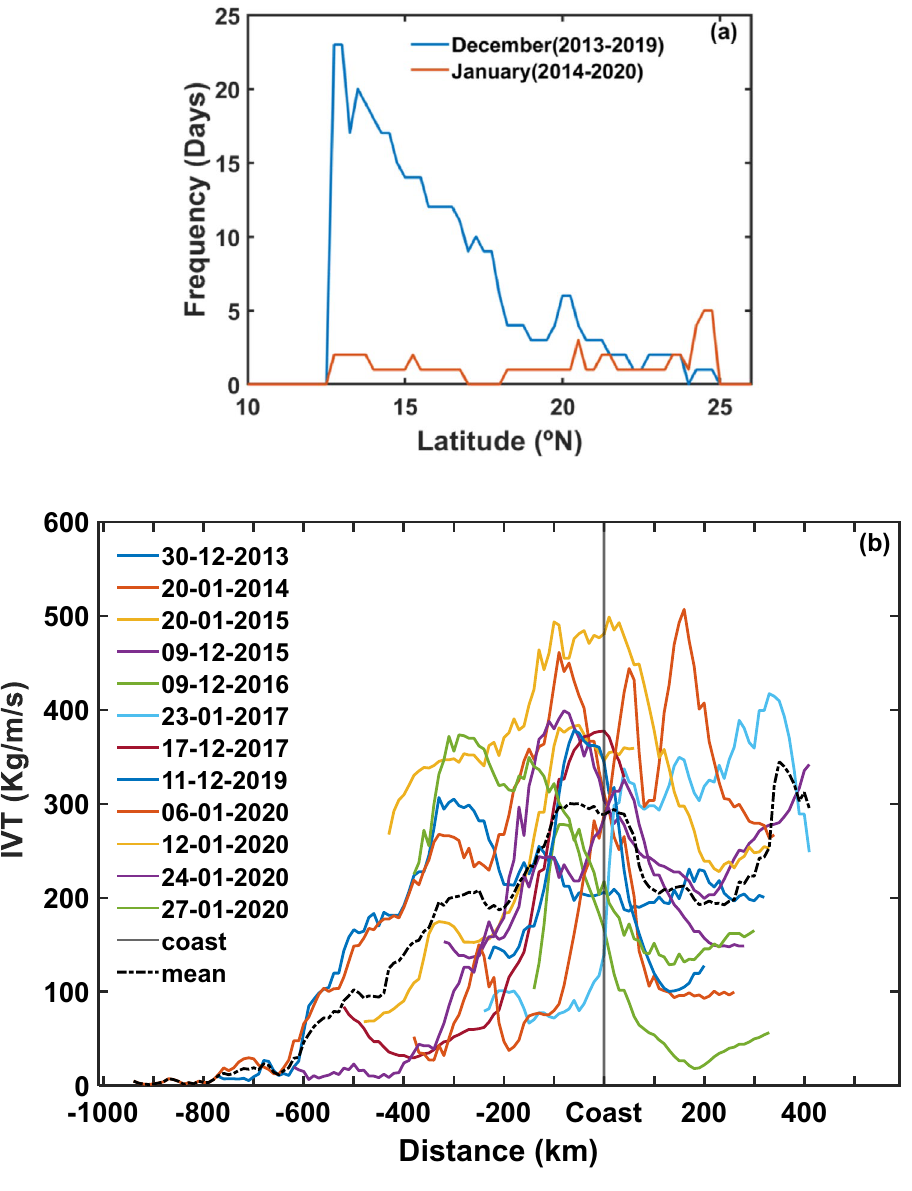
Figure 2. AR-landfall frequency along the west coast of India. ( a ) Frequency of AR-landfalls along the west coast of India during 2013–2020 estimated based on IVT and PWV values. ( b ) The AR-landfall transects along the west coast of India correspond to the maximum IVT as close as possible to the midpoint of each transect on the coast during 2013–2020. The negative and positive values on the horizontal distance scale represents respectively offshore and inland sides of AR axis with reference to the coast. Black dashed line represents the mean IVT of all